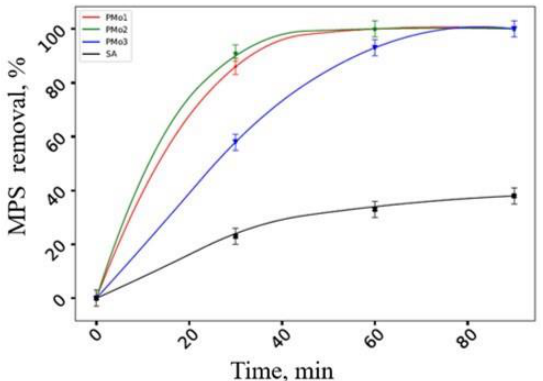
Figure 9. Methylphenyl sulfide (MPS) removal versus time.